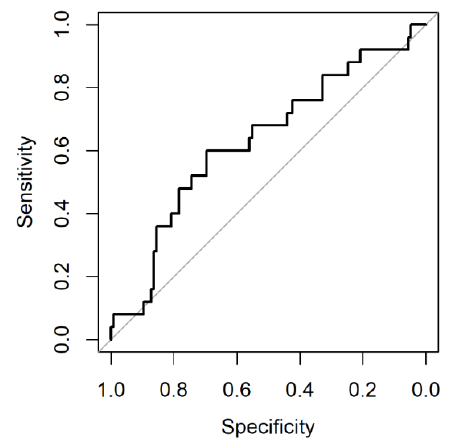
Figure 1. Receiver operator curve for Colon Life nomogram in QUALITAS patients.